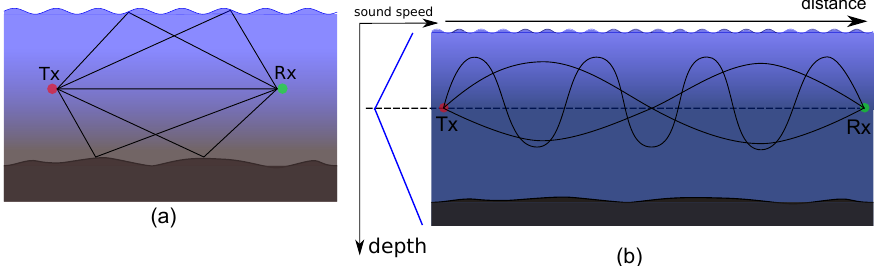
Figure 1. Multipath propagation of acoustic signal: ( a ) in shallow sea for short distance ( b ) in deep sea for long distance. The solid lines between Transmitter (Tx) and Receiver (Rx) are some of the possible rays between them. In shallow sea the sound speed does not change significantly while in deep sea sound speed varies significantly with depth and typically follow Munk profile as in left panel of subfigure ( b